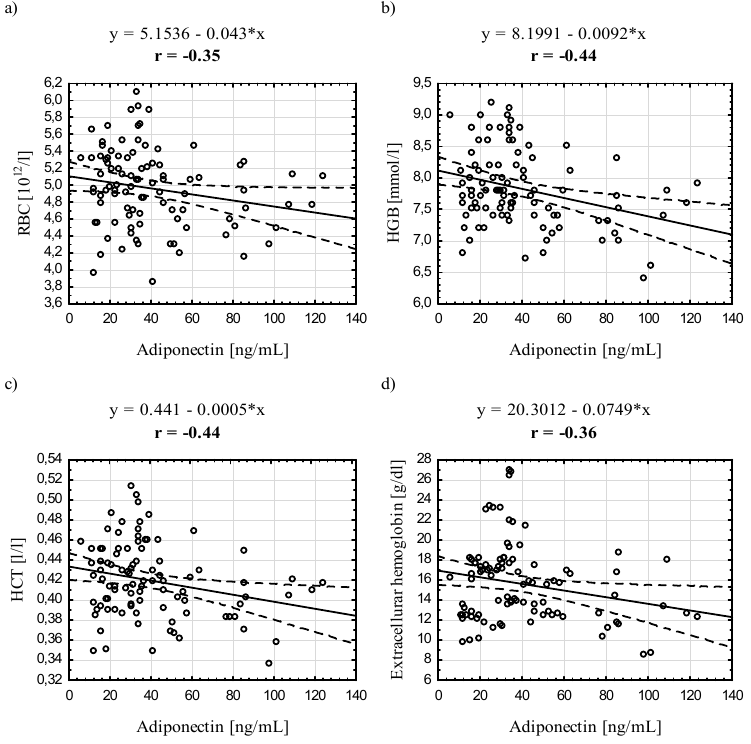
Figure 1. Scatter plots for the correlation ( p < 0.05) between adiponectin and selected erythroid indicators in the study